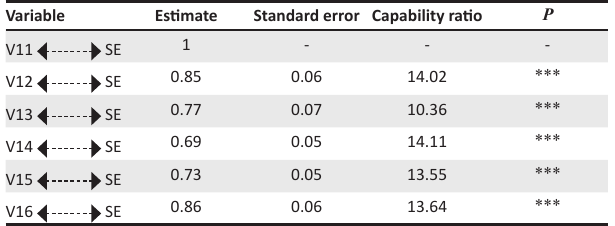
TABLE 4: Levels of